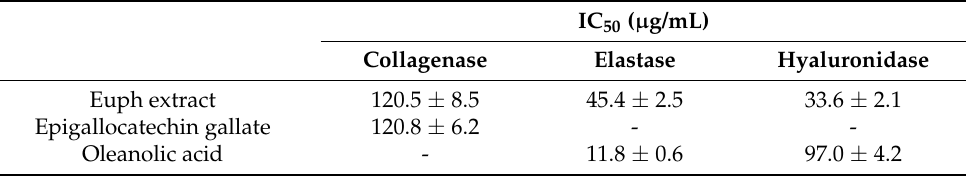
Table 1. Collagenase, elastase, and hyaluronidase inhibition, expressed as IC 50 values ( µ g/mL), of E. characias (Euph) extract. Standard compounds were epigallocatechin gallate for collagenase and oleanolic acid for both elastase and hyaluronidase.